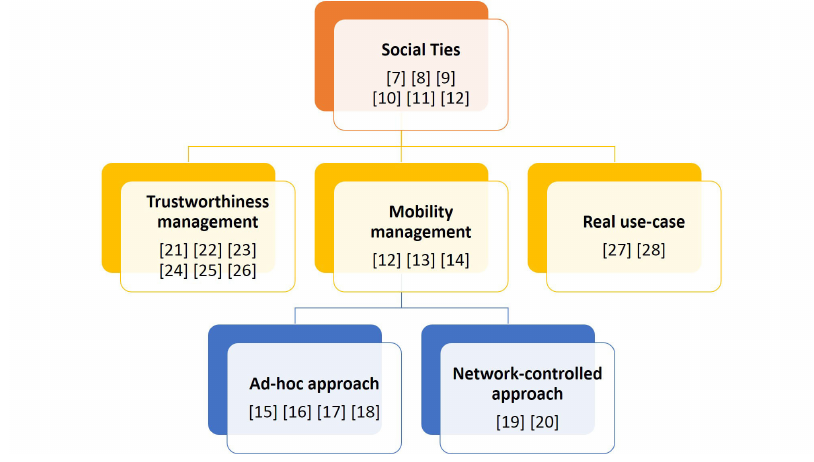
Figure 2. Classification